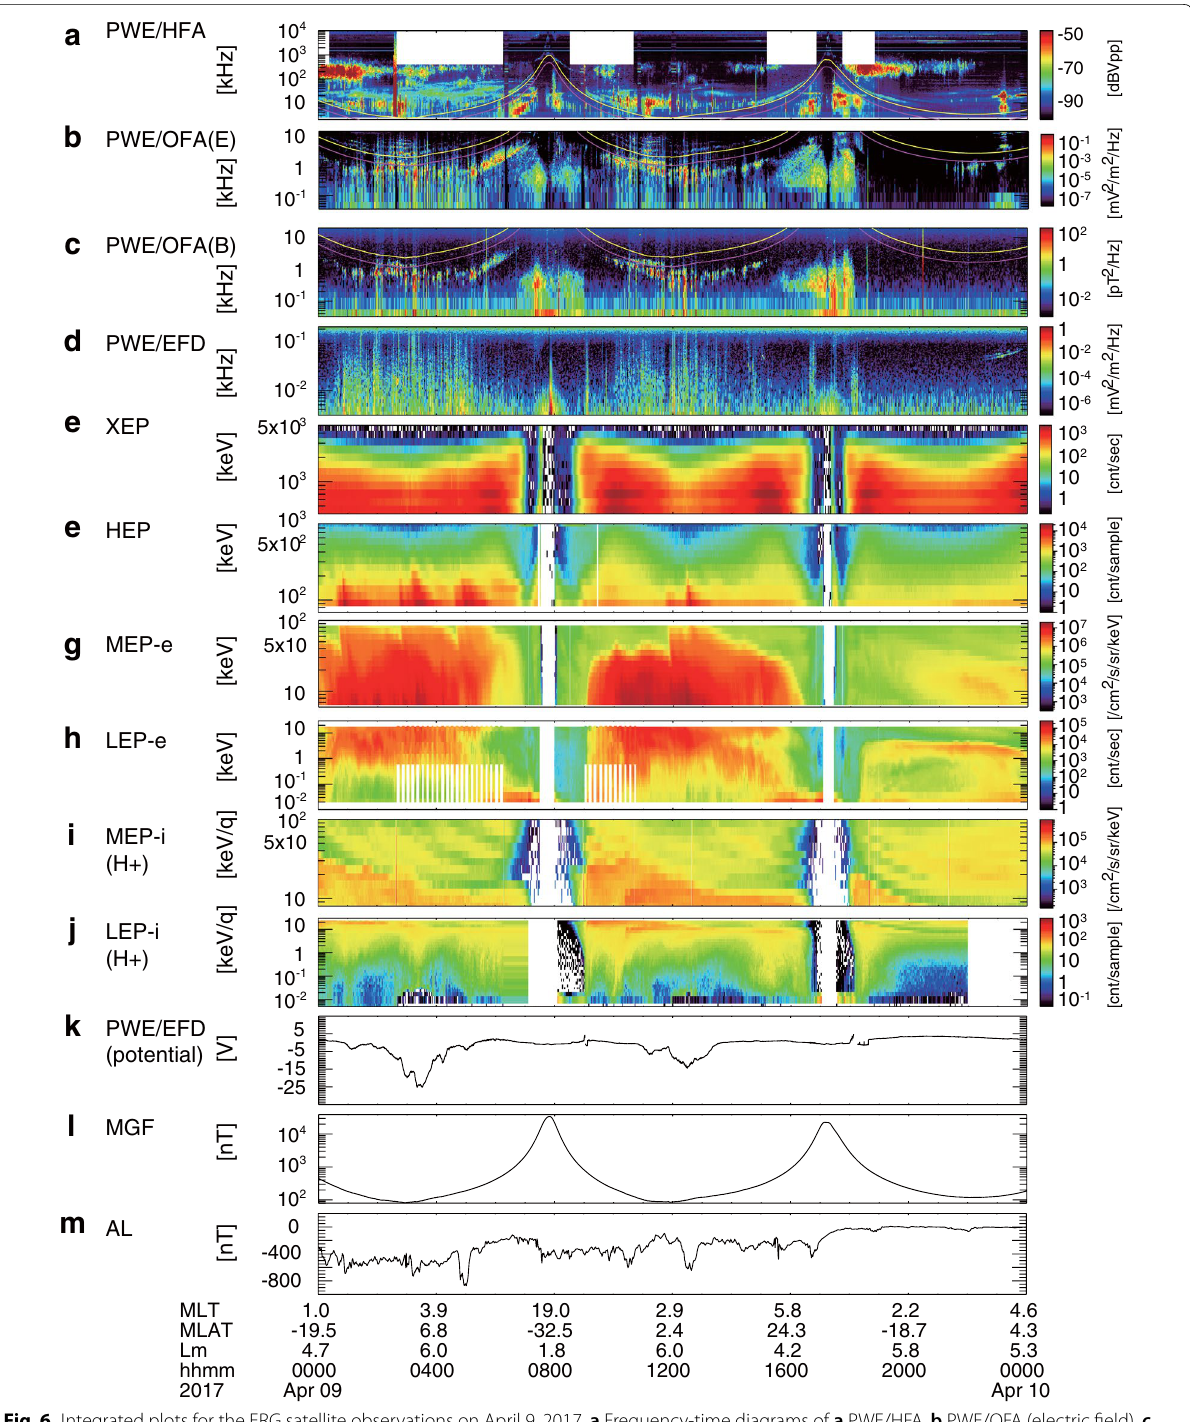
Fig. 6 Integrated plots for the ERG satellite observations on April 9, 2017. a Frequency‑time diagrams of a PWE/HFA, b PWE/OFA (electric field), c PWE/OFA (magnetic field), and d PWE/EFD. Energy‑time diagrams of electrons from e 400 keV to 5 MeV by XEP, f 70–1000 keV by HEP‑L, g 7–87 keV by MEP‑e, and h 17 eV to 20 keV by LEP‑e. Energy‑time diagrams of protons from i 5–110 keV/q by MEP‑i and j 10 eV/q to 25 keV/q by LEP‑i. k Satellite potential measured by PWE/EFD, l ambient magnetic field measured by MGF, and m AL index. Yellow and magenta lines in panels a – c indicate the electron gyrofrequency and the half electron gyrofrequency derived from the MGF observations at the satellite